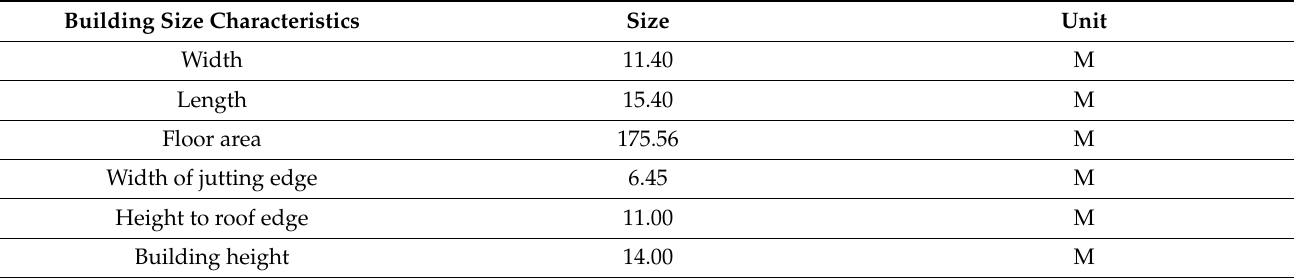
Figure A30. Thermographic aerial images of the reference building (north, east, and west orientation). Table A32. Building size characteristics of the reference building